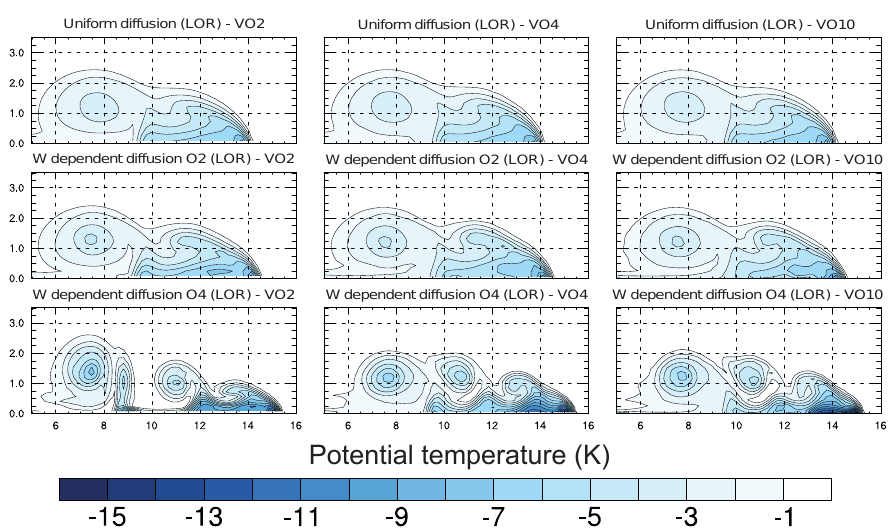
Figure 13. Straka density current test at vertical order 2, 4, and 10. Coarse, evaluation resolution of (cid:49)x = 190m and (cid:49)z = 160m shown. Vertical flow-dependent diffusion of order 2 and 4 (rows 2 and 3) is compared with the reference solution where an explicit second-order diffusion with ν 0 = 75m 2 s − 1 is used (top row). Results for Lorenz (LOR) staggering shown. Contour interval: 1 . 0K.